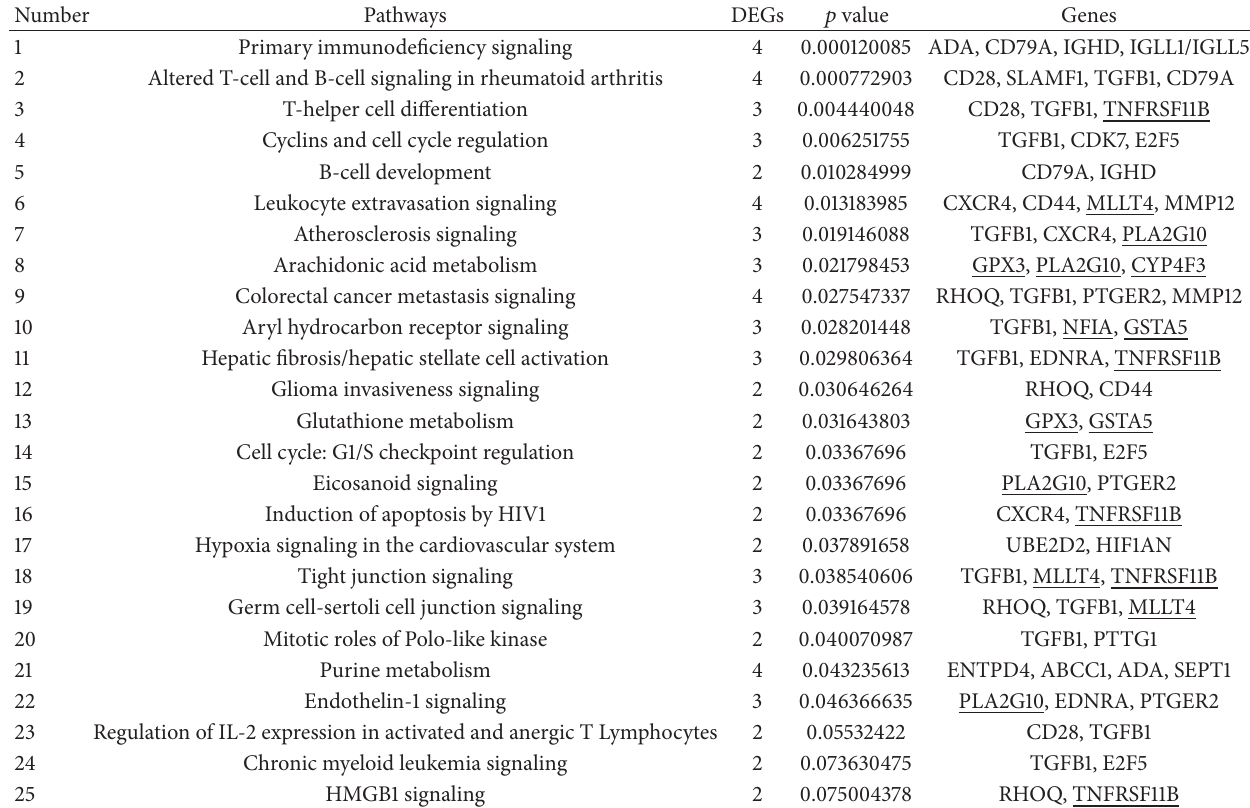
Table 2: Top 25 canonical pathways associated with IPH in Ingenuity